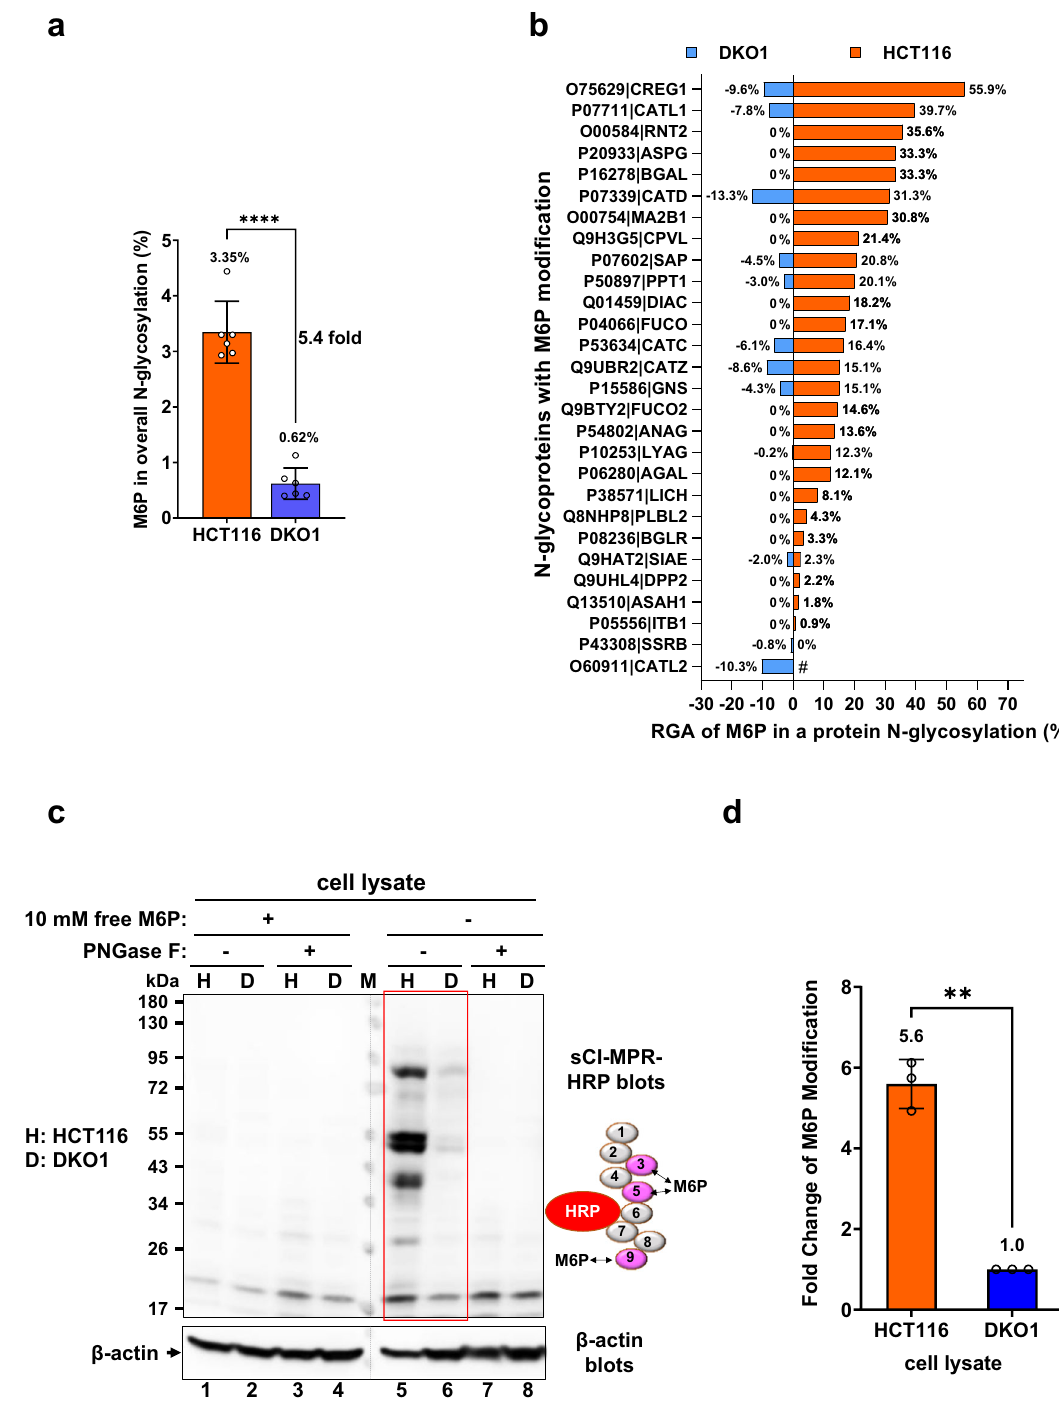
Fig. 6 M6P modi fi cation is more than 5-fold higher in HCT116 cells than that in DKO1 cells. Comparison of overall ( a ) and individual ( b ) M6P N-glycosylation in HCT116 and DKO1 cells detected by mass spectrometry. Please note ( a ) in this fi gure is derived from Fig. 4a and is presented to show the correlation between M6P modi fi cation levels detected by mass spectrometry and those observed by Western blot analyses shown in ( c ) and ( d ) in this fi gure. RGA of M6P in DKO1 is presented with a negative symbol as a result of the plotting method. Ignore the negative sign and read the absolute value. #, O60911|CATL2 was not detected in HCT116 cells. c , d Western blots show M6P modi fi cation is signi fi cantly higher in HCT116 cells (H) than in DKO1 cells (D). Representative Western blots are shown in the c), and the quanti fi cation summary of M6P modi fi cation from three independent Western blots is shown in ( d ). In the Western blot, soluble cation-independent M6P receptor (sCI-MPR) conjugated with HRP (illustrated) was used to probe M6P level in HCT116 and DKO1 cell lysates. The M6P binding domains (Domains 3, 5, and 9) are highlighted in dark red. To demonstrate the speci fi city of sCI-MPR- HRP, 10 mM free M6P was added to a parallel Western blot to compete off sCI-MPR binding to M6P-modi fi ed N-glycoproteins. PNGase F deglycosylated cell lysates were also used as negative controls. β -actin blot serves as a protein loading control. H, HCT116; D, DKO1; M, protein standard marker; **, P < 0.01; ****, P < 0.0001, mean with SD, t-test, two-tailed, n = 6 in ( a ), n = 3 in ( d